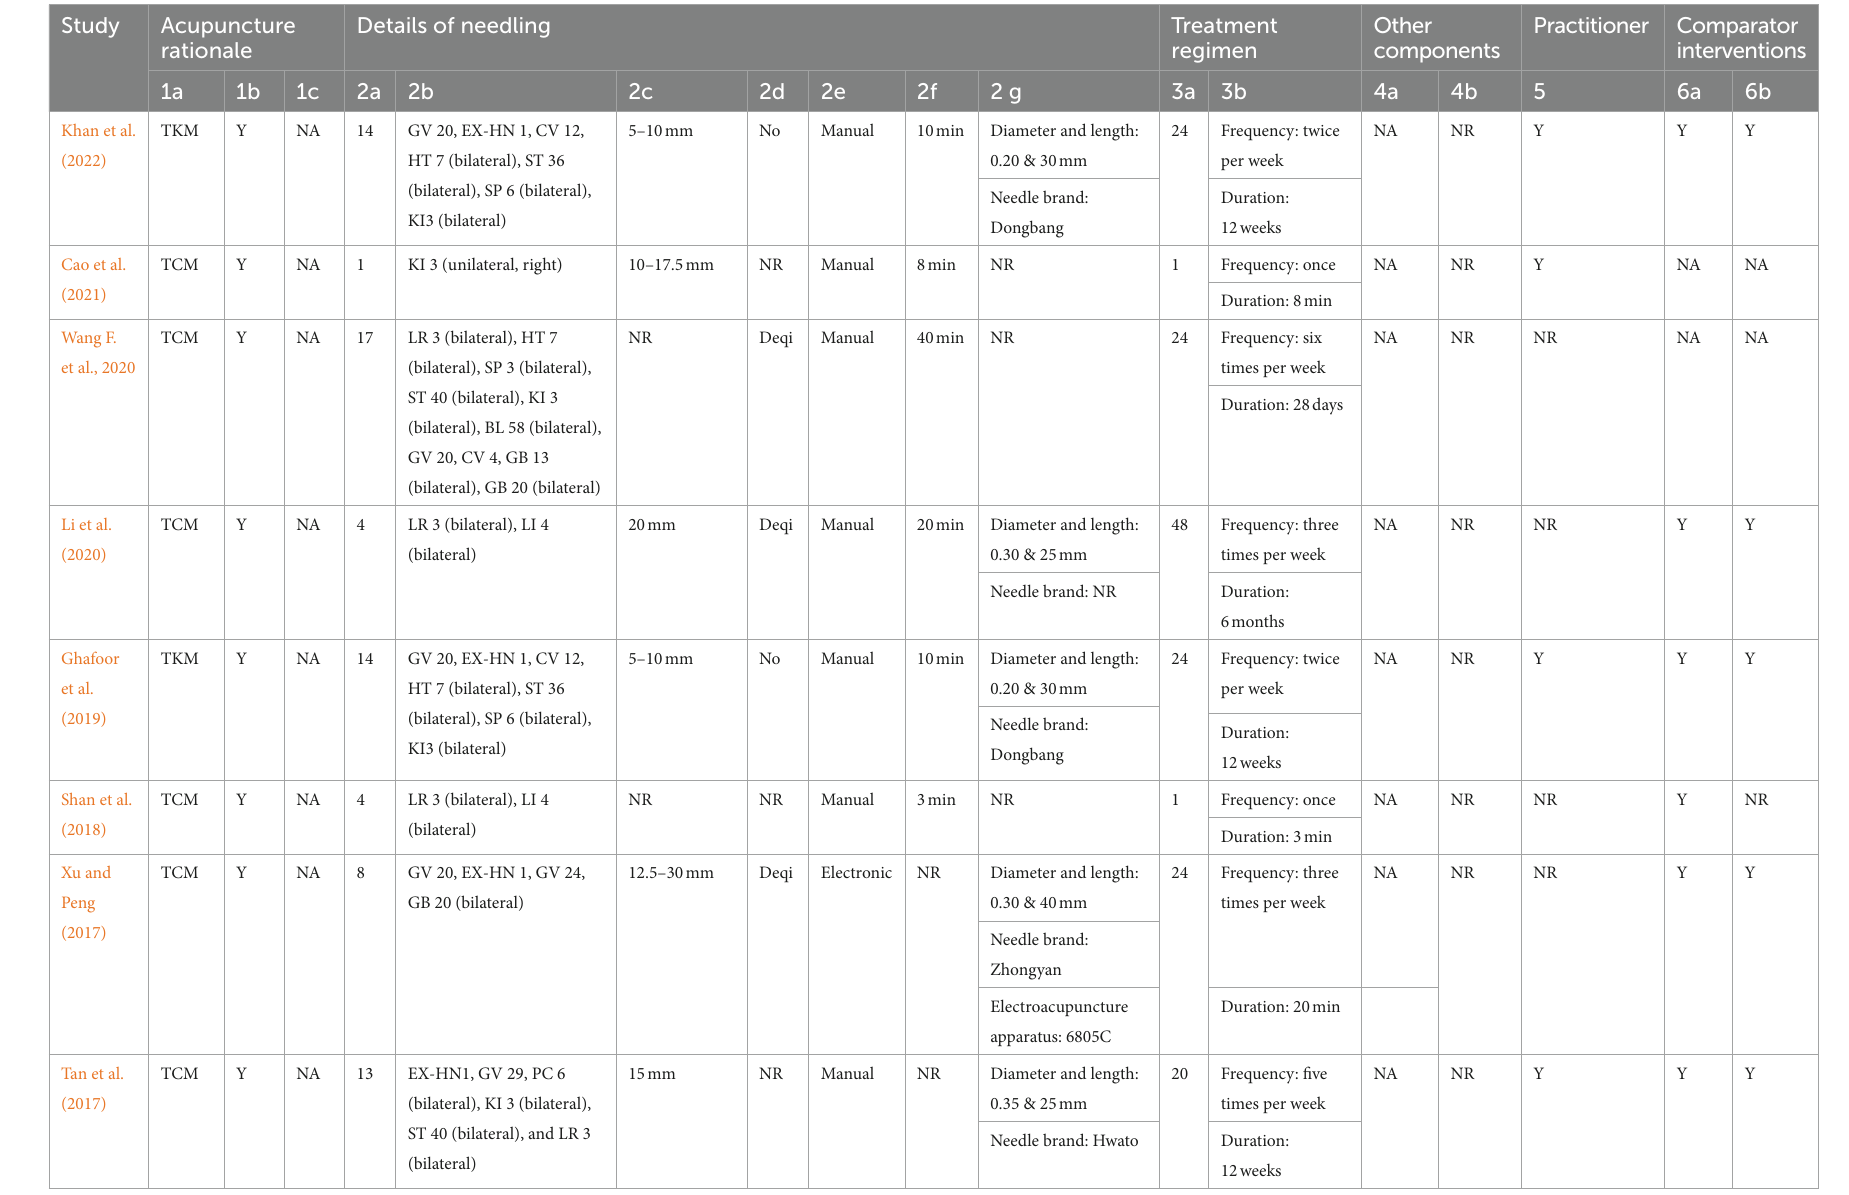
Needle brand: Zhongyan Electroacupuncture apparatus: 6805C